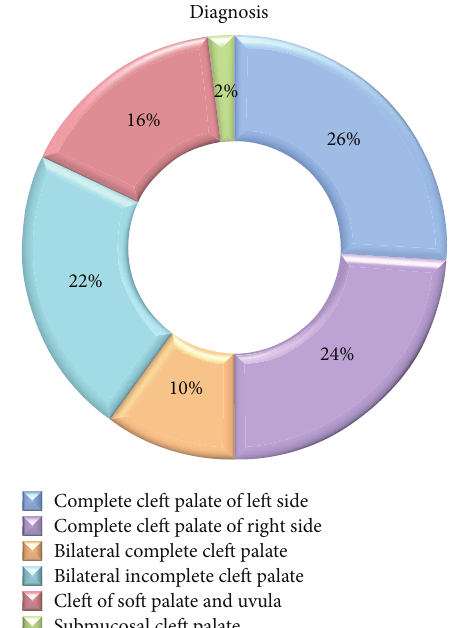
Figure 4: Diagnosis-wise distribution of study